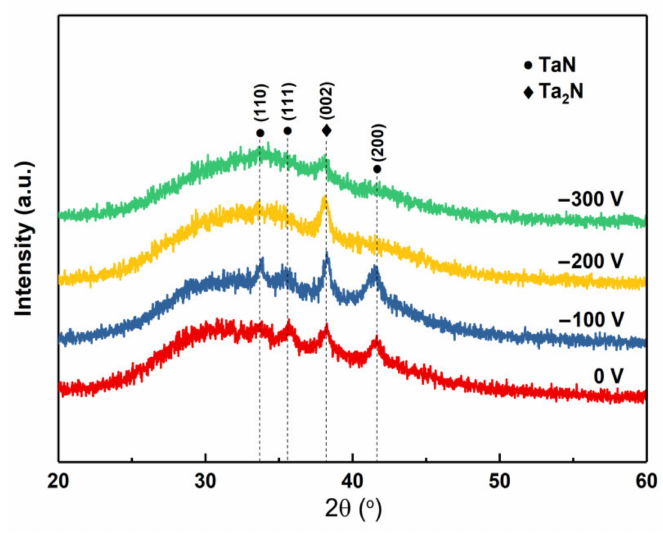
Figure 3. XRD patterns of the TaN x coatings deposited with various bias